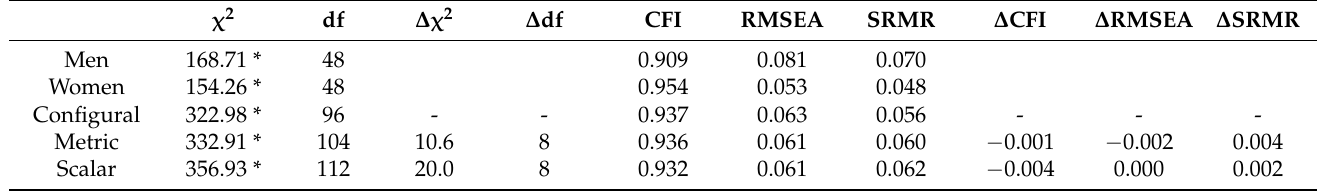
Table 3. Measurement invariance by gender models and goodness-of-fit indices. Reference group: